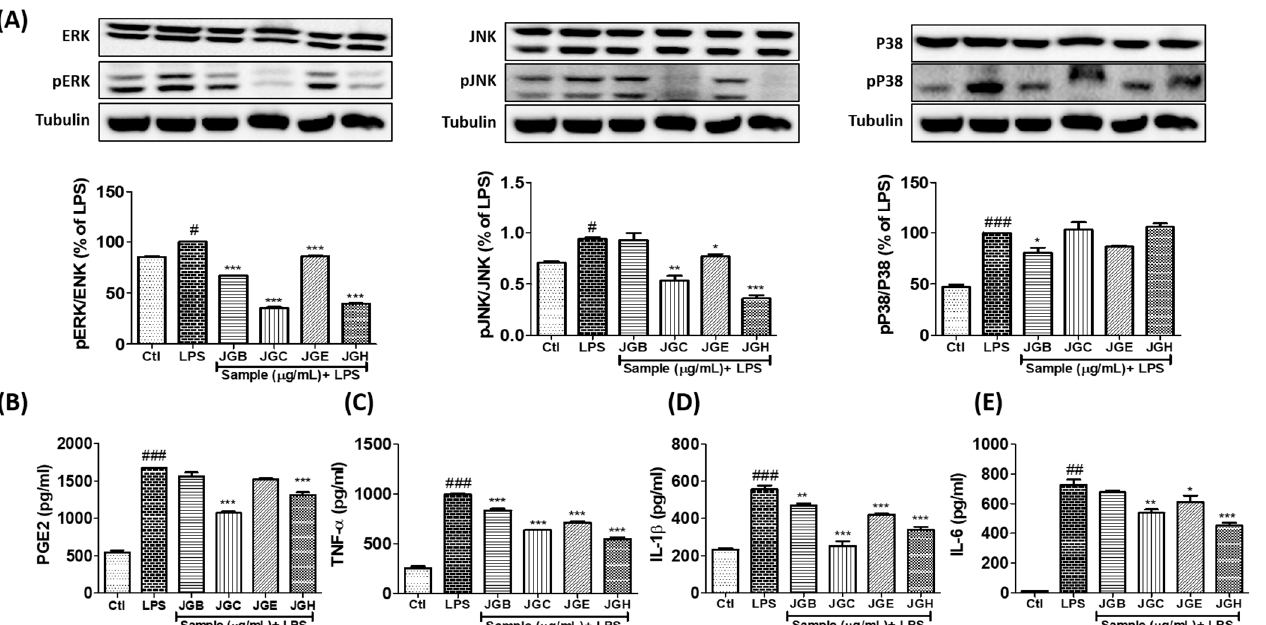
Figure 2. A. holophylla subfractions controlled mitogen-activated protein kinase (MAPK) protein expression and secretion of pro-inflammatory cytokines and mediators. Western blot analysis of BV2 cells pre-treated with the JGB, JGC, JGE, and JGH fractions and activated with LPS. ( A ) Expression of MAPKs and their quantification using ELISA. Tubulin was used as a loading control. BV2 cells were treated with 10 µg/mL JGB, JGC, JGE, and JGH and incubated with 100 ng/mL LPS for 24 h; secreted inflammatory mediators were measured using ELISA. ( B – E ) Amount of secreted prostaglandin E2 (PGE2), tumor necrosis factor alpha (TNF- α ), interleukin (IL)-1 β , and IL-6. * p < 0.05, ** p < 0.01, and *** p < 0.001 indicate significant differences compared with treatment of LPS alone, while # p < 0.05, ## p < 0.01 and ### p < 0.001 indicate significant differences compared with the untreated control group. Ctl indicates untreated control cells, LPS indicates LPS-treated cells.